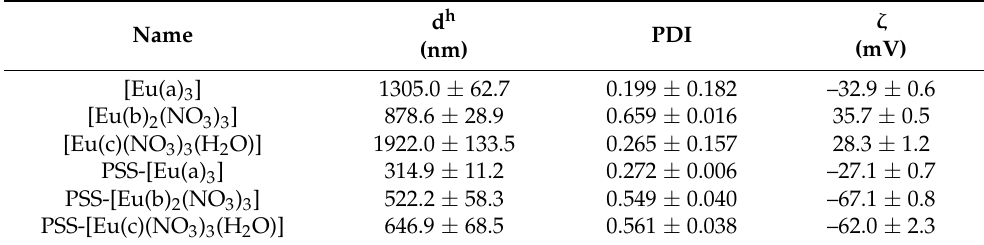
Table 2. DLS data (hydrodynamic diameter (d h ), polydispersity index (PDI), and electrokinetic potential ( ζ )) for [Eu( L ) x ] precipitates and PSS-[Ln( L ) x ] colloids in water.